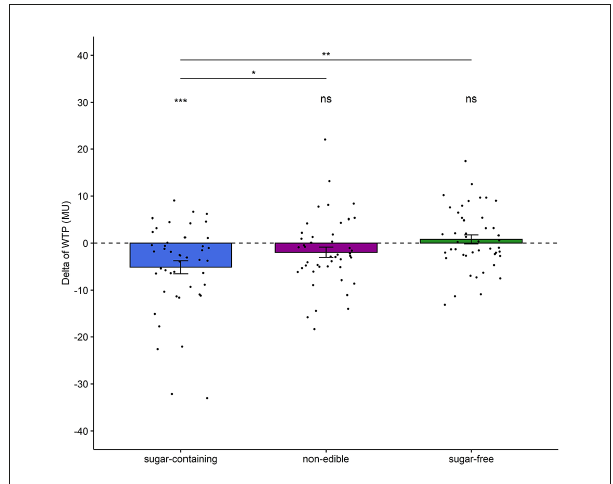
FIGURE2 Changes in participants’ WTP for sugar-containing, sugar-free and non-edible products after listening to the healthy eating call. A dashed horizontal line at 0 indicates no change in WTP. Dots represent individual subjects. Statistically significant differences are denoted with asterisks (* p < 0.05, ** p < 0.01, *** p < 0.001). The “ns” denotes that the delta of WTP for neither the sugar-free nor the non-edible products was significantly different from